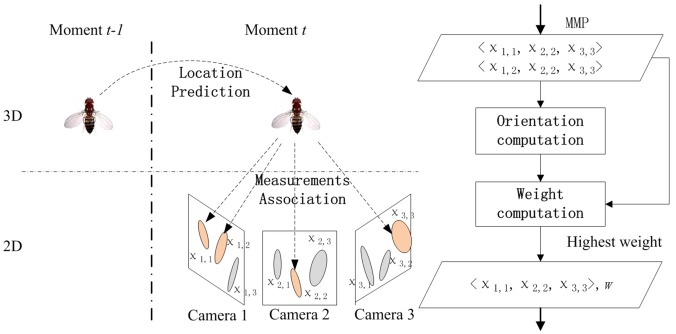
Overview of the tracking algorithm.The fruit fly is flying in 3D space. By exploiting the particle filtering solution, there are N (we set in our experiments N = 200) particles sampling the posterior distribution of the location of a target at moment t. Each particle includes the location’s prediction at moment t. The tracking algorithm computes the orientation and weight of each particle using the MMP associated with the particle at moment t. If there are more than one MMP (e.g. since the particle is associated with two measurements in Camera 1, the algorithm thereby generates two MMPs (χ
1,1, χ
2,2, χ
3,3) and (χ
1,2, χ
2,2, χ
3,3)), the algorithm choose the MMP having highest weight (e.g. (χ
1,1, χ
2,2, χ
3,3)) and the orientation computed by the MMP.